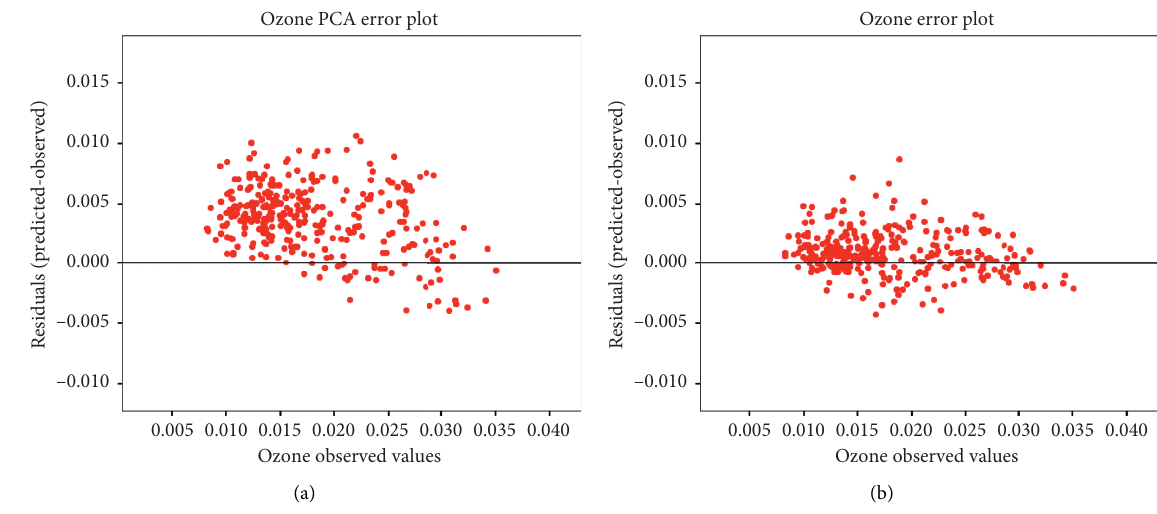
Figure 16: (a) PCS SVR-RBF forecasting errors plotted against observed ozone values and (b) SVR-RBF forecasting errors plotted against observed ozone